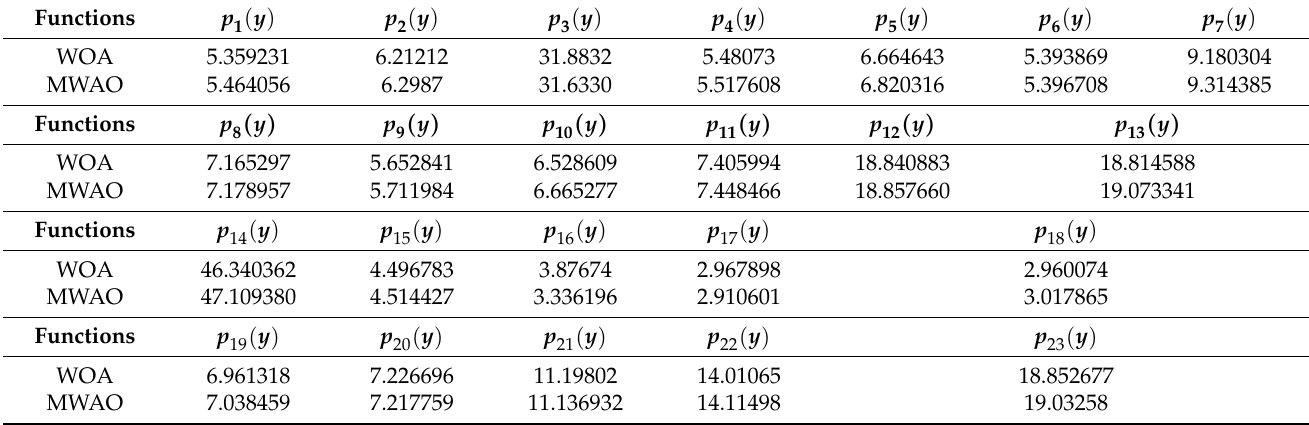
Table A3. Comparison of implementation time (in seconds) of WOA and MWAO.